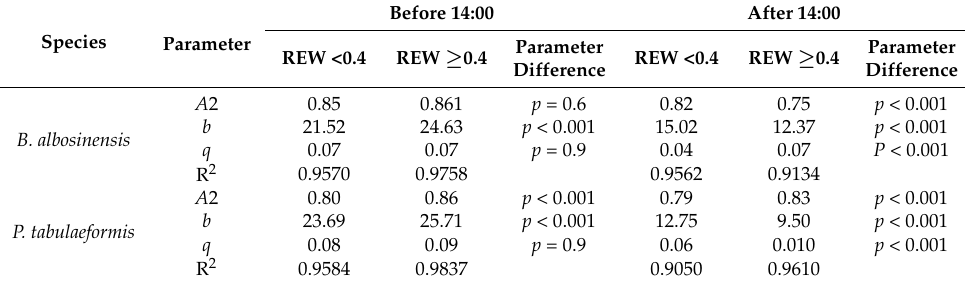
Table 3. Results of regression analyses for the relationships of the normalized F d in response to VT in the daytime hours for respective species in Figure 7. The datasets of the normalized F d and VT covered periods with REW <0.4 and REW ≥ 0.4 at different times in August, respectively. The e